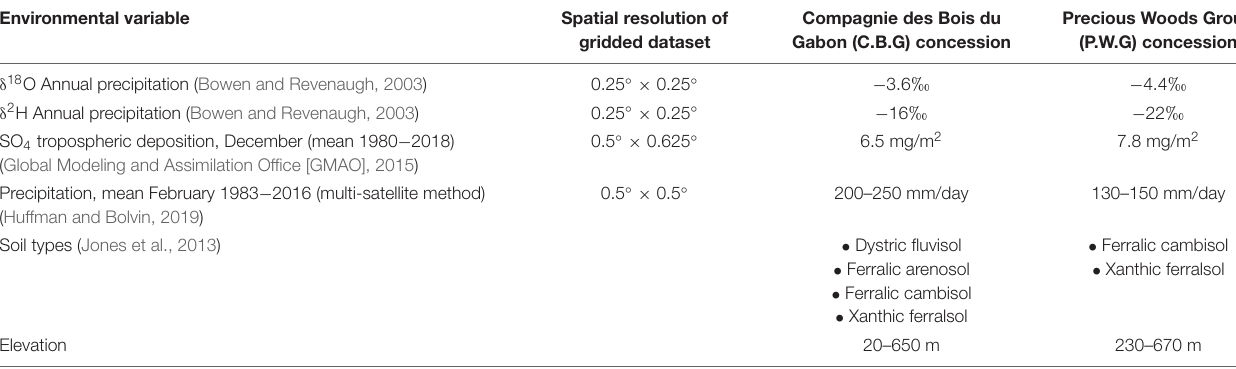
TABLE 1 | Environmental differences between the P.W.G and C.B.G concessions. Environmental variable Spatial resolution of